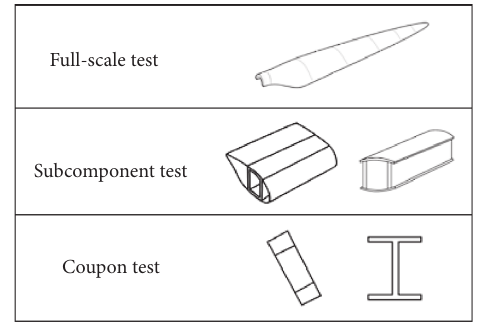
Figure 1: Test methods of the wind turbine blade.